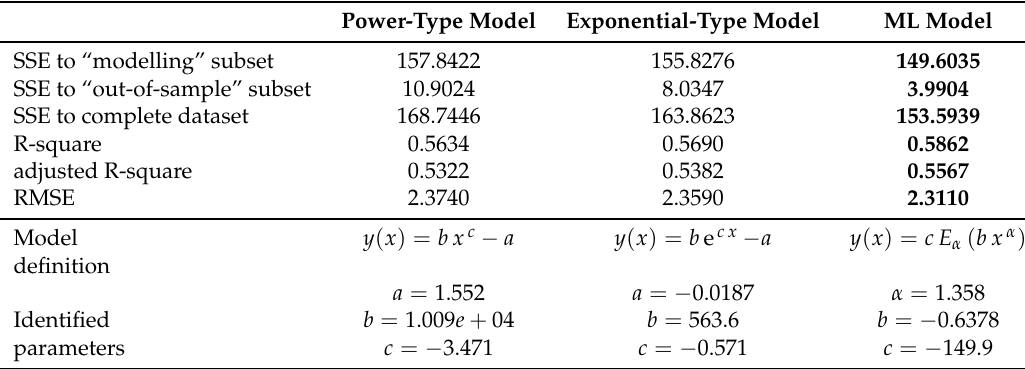
Table 2. The statistical results of the French Phillips curve